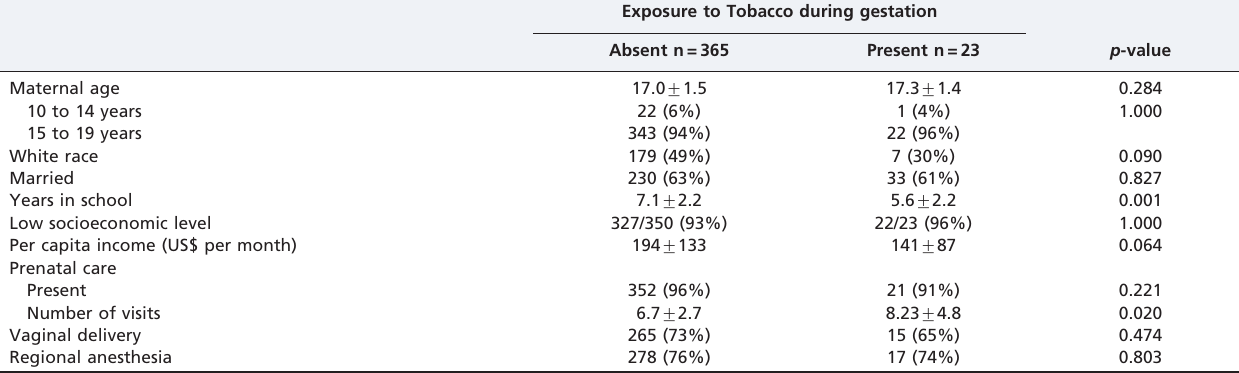
Table 1 - Demographic characteristics of the adolescent